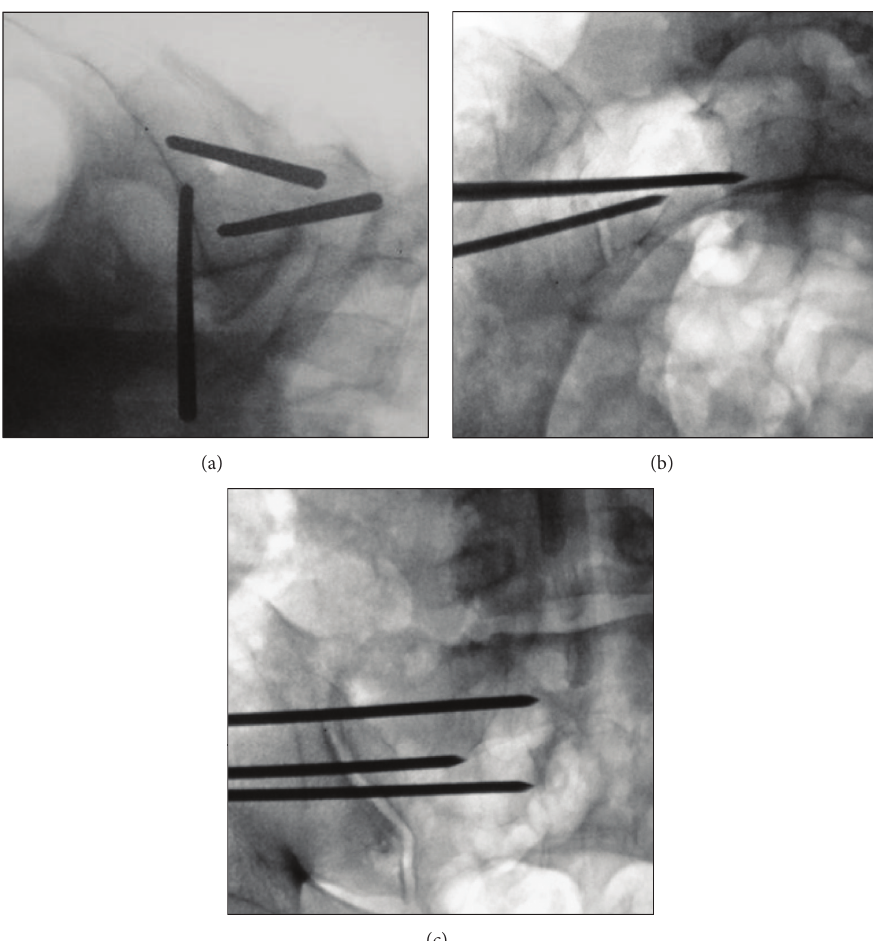
Figure 2: Lateral (a), inlet (b), and outlet (c) views of guide wire placement through the ilium, across the sacroiliac joint, and into the sacrum. Note the difficulty in visualizing the sacral foramen in